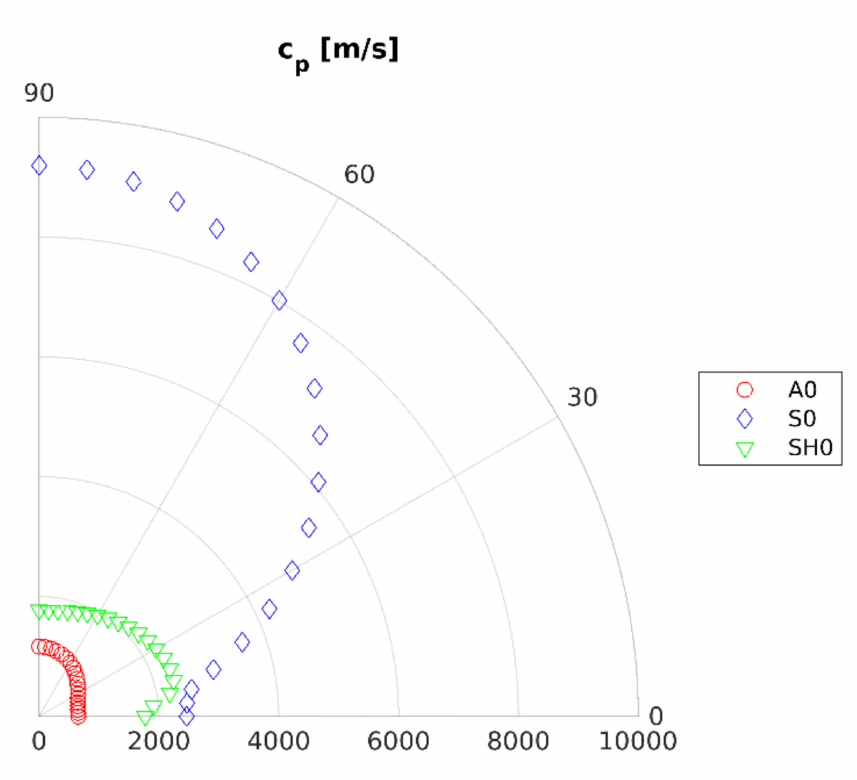
Figure 2. Polar plot of phase velocity for frequency 40